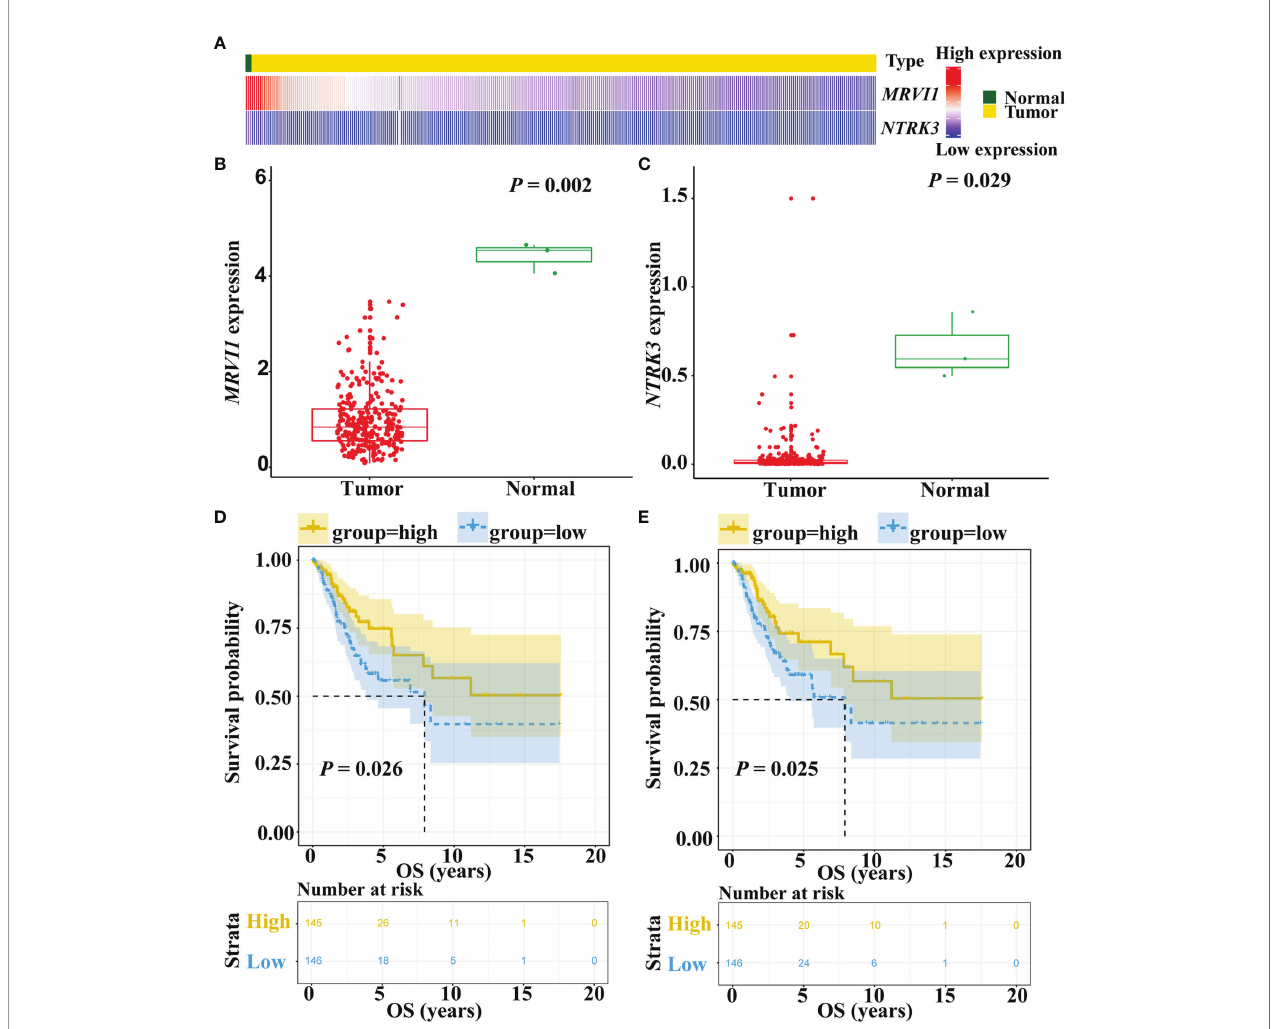
FIGURE 5 | Prognostic values of MRVI1 and NTRK3 . (A) Hierarchical clustering of MRVI1 and NTRK3 ; Expression of MRVI1 (B) and NTRK3 (C) in 304 cervical cancer patients and 3 normal cervical tissues. The MRVI1 and NTRK3 expression levels (log2(FPKM+1)) are signi fi cantly decreased in cervical cancer patients compared with the normal controls. (D, E) Kaplan – Meier curves show that low expression of MRVI1 and NTRK3 have worse prognosis than that of the high expression of MRVI1 and NTRK3